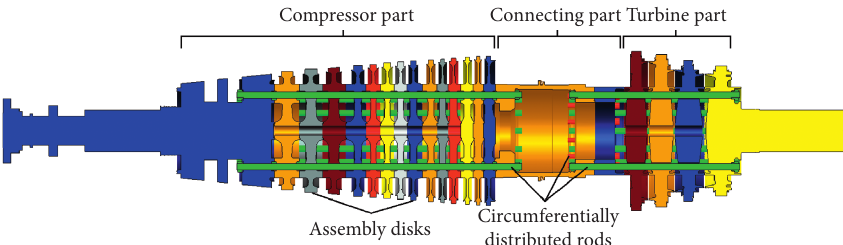
Figure 1: Structure of an F-class gas turbine